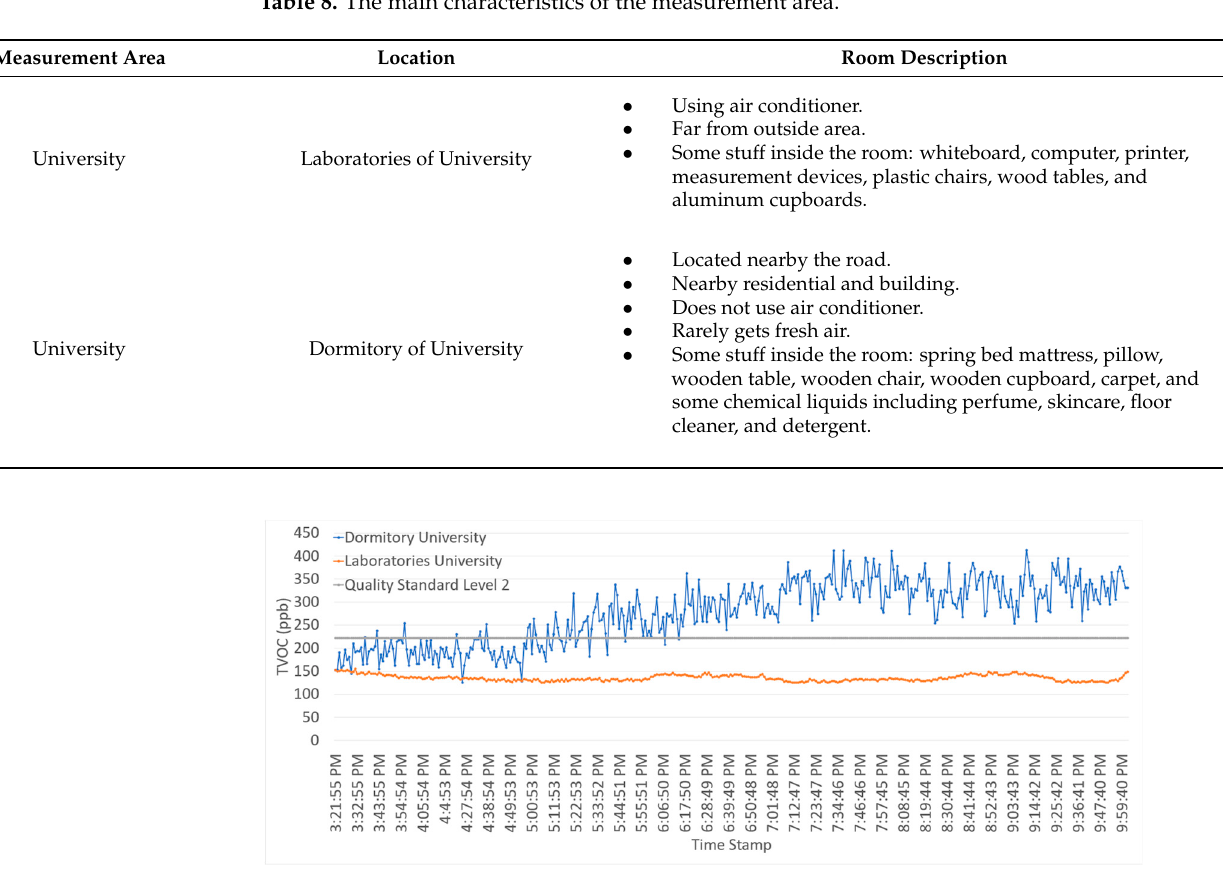
Figure 16. TVOCs measurement results.